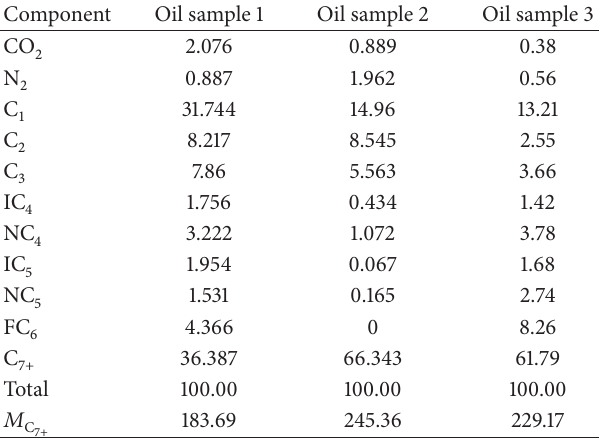
Table 1: Compositional analysis results of three oil samples with C 7+ molecular weight in mole